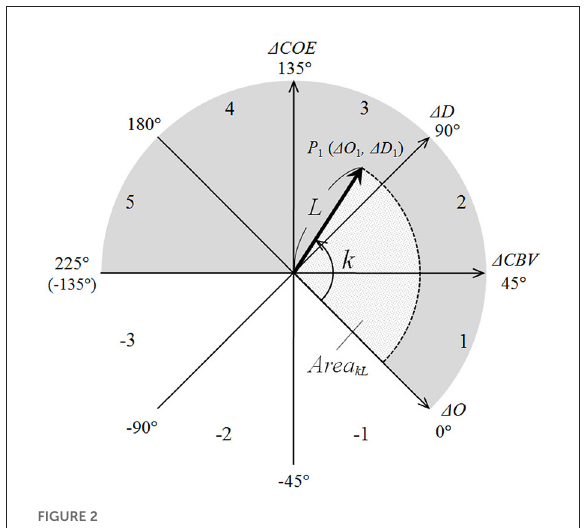
FIGURE2 CORE vector coordinates. Values for k (in degrees) are shown at the tips of the axes. Phase numbers are shown in each octant